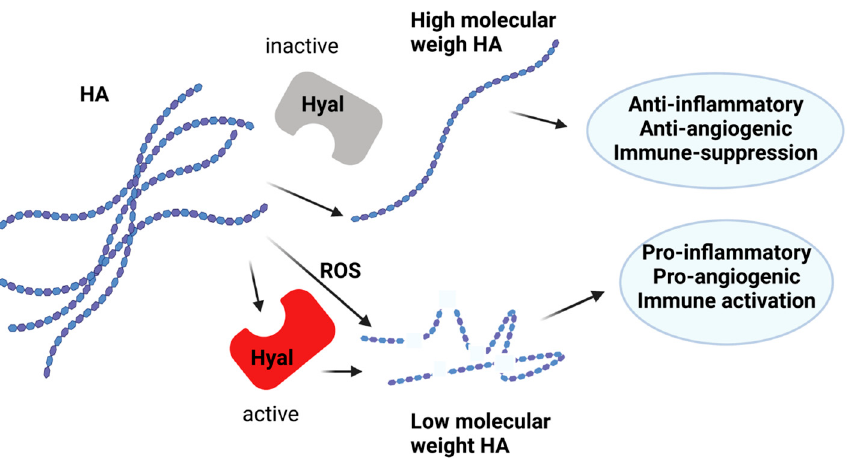
Figure 4. Inflammatory processes are controlled by HA of various molecular weights. An inactive hyaluronidase (Hyal) allows HMW HA to induce anti-inflammatory, anti-angiogenic, and immune- suppressive effects; an active Hyal cleaves HA to LMW HA fragments that inflict pro-inflammatory, pro-angiogenic, and immune activation effects. Table 1. Different roles of LMWHA and HMWHA in inflammation events.